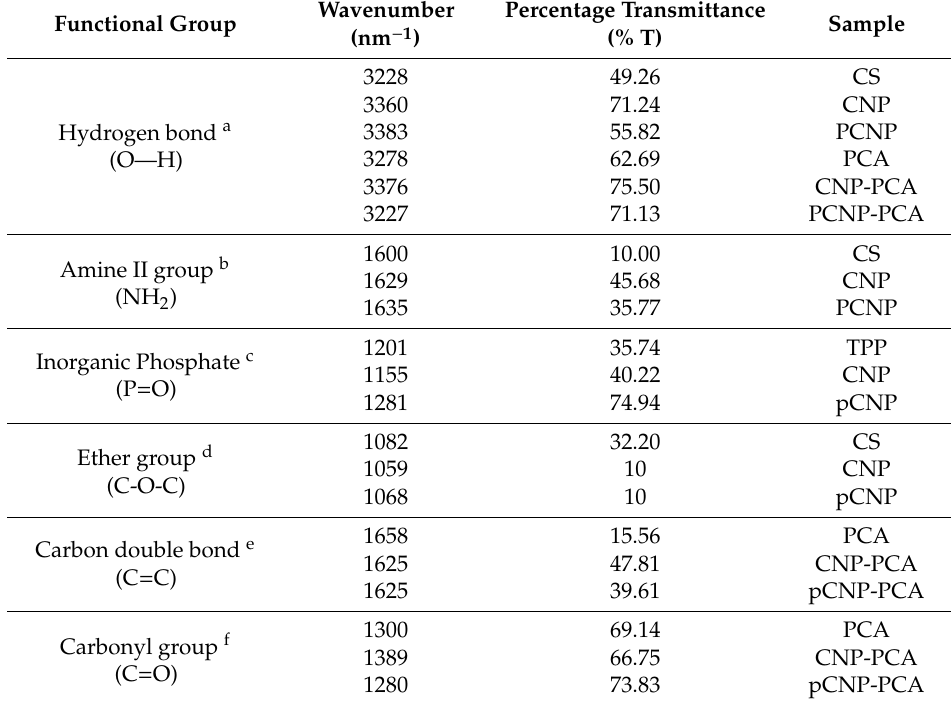
Table 2. The chemical functional groups present in CS, TPP, PCA, CNP, PCNP, CNP-PCA and PCNP-PCA. All the important functional groups detected were listed in the table with their respective wavenumber and percentage of